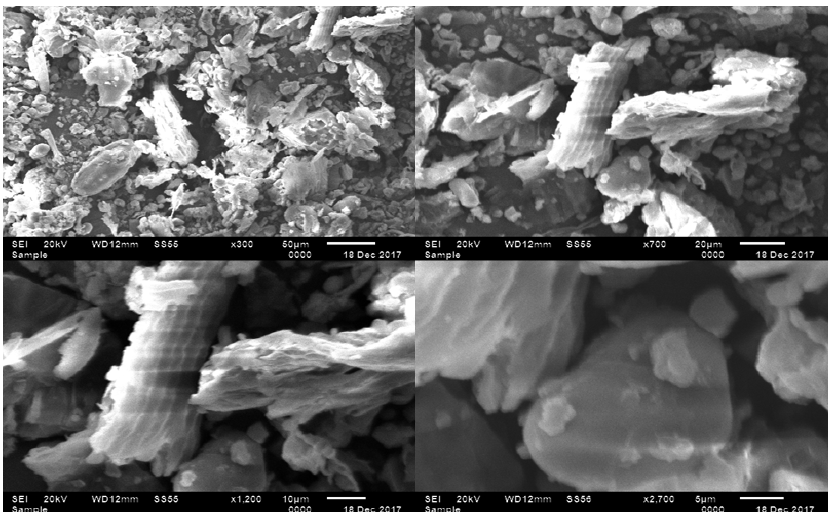
Figure 2. Scanning Electron Micrograph (SEM) of mixed adsorbent after adsorption.